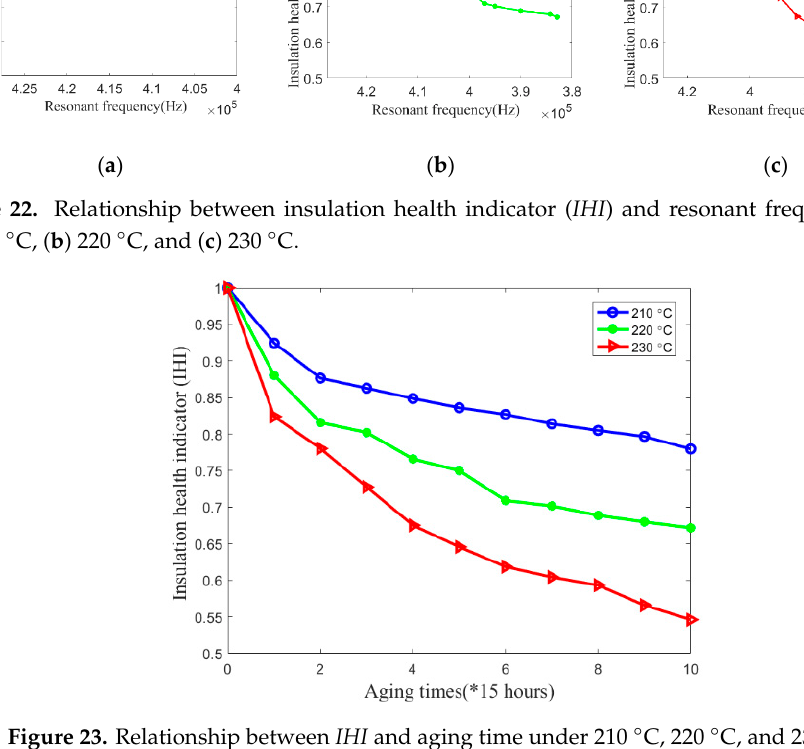
Figure 23. Relationship between IHI and aging time under 210 °C, 220 °C, and 230 °C.